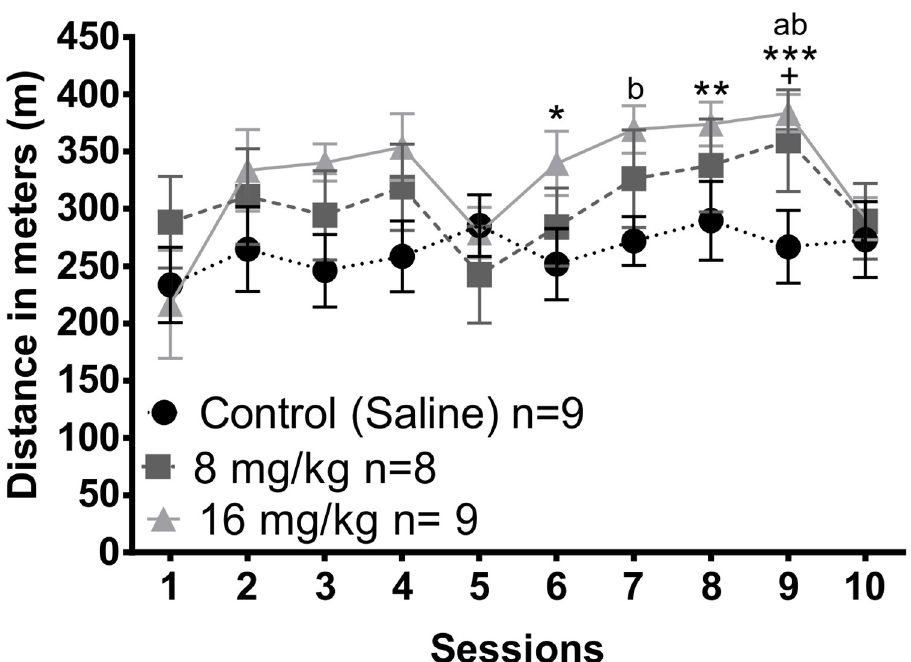
Fig 3. Distance traveled in the running wheel test in the different group of animals along the 10 weeks of testing. Twenty-four hours before sessions 1, 5 and 10 subjects were injected with saline, 8 mg/kg or 16 mg/kg of MnCl 2 . Data presented as mean +- SEM. + Difference between 8 mg/kg and control group, p < 0.05. � Difference between 16mg/kg and control group, p < 0.05; �� , p < 0.01; ��� , p < 0.001. a Difference from session 5 within the 8 mg/kg, p < 0.05. b Difference from session 1 within the 16 mg/kg, p <